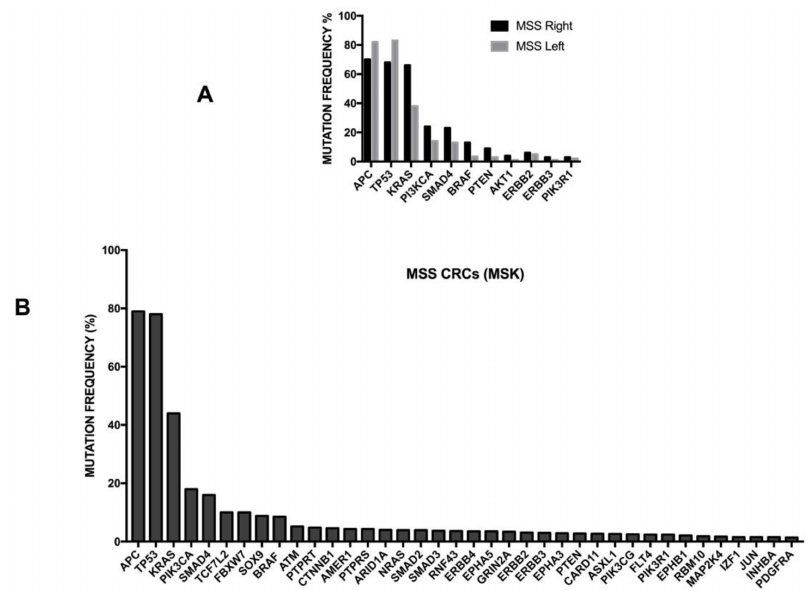
Figure 7. Recurrently altered genes in advanced colorectal patients. ( A ) Frequency of mutations of the whole population of MSS colorectal cancers. ( B ) Frequency of mutations in MSS colorectal cancer subdivided into left and right according to tumor location. The figure shows the data reported by Yaeger et al.